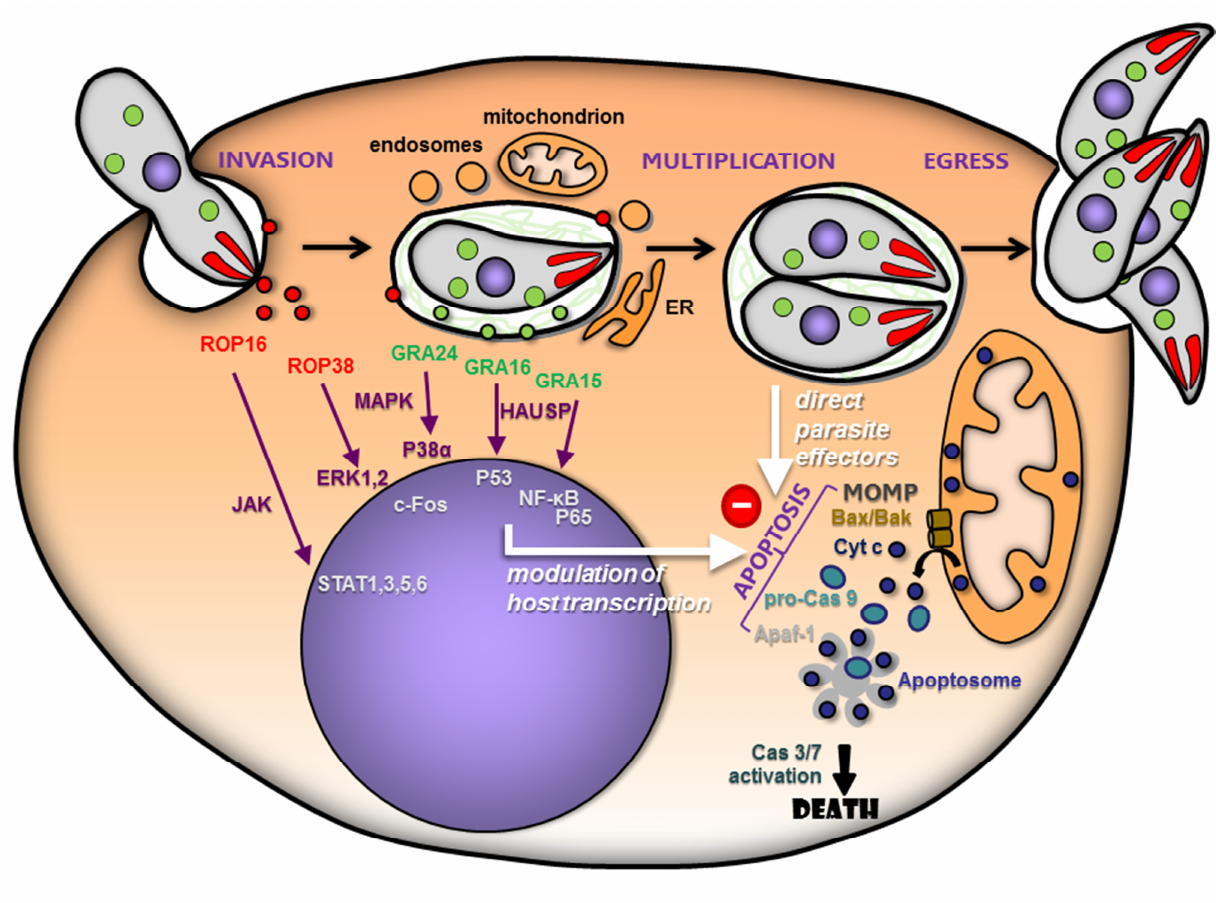
FIGURE 1: Schematic representation of Toxoplasma / host interactions, with a particular focus on the control of host apoptosis. The tachyzoite form actively invades its host cell and establishes itself in a parasitophorous vacuole in which it will multiply before egressing, and as a consequence destroy its host. Through the course of infection, the parasite is able to sequentially secrete rhoptry (ROP) and dense granule (GRA) proteins that will lead to the extensive modification of its host cell. Host organelles are recruited around the parasitophorous vacuole, potentially to serve as a nutrient source. The parasite is also able to modulate host protein expression by acting on host signaling pathways and transcription factors. This will influence host survival by altering the expression of key regulators of apoptosis, but as yet uni- dentified parasite effectors are also able to directly inhibit host apoptosis by interfering with apoptosome formation. MOMP: mitochondrial outer membrane